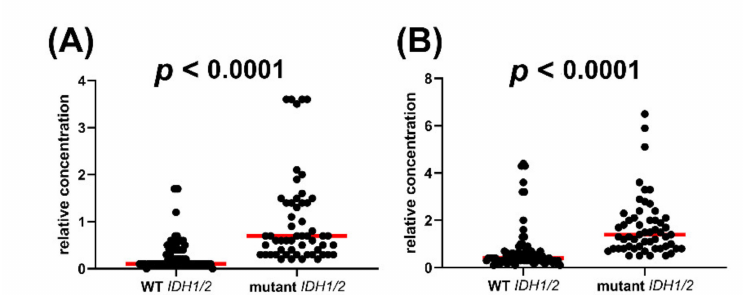
Figure 2. Plasma concentrations of ( A ) (2 R )-hydroxyglutaric acid and ( B ) (2 R ,3 S )-dihydroxybutanoic acid in patients with WT and mutant IDH1 / 2 . Red horizontal lines represent median values and distributions were compared using the nonparametric Mann–Whitney test. Note the similar distribution of these two metabolites and the presence of outliers in the IDH1 / 2 WT genotypes, suggesting the presence of mutations additional to IDH1R132 and IDH2R140 that were not determined.